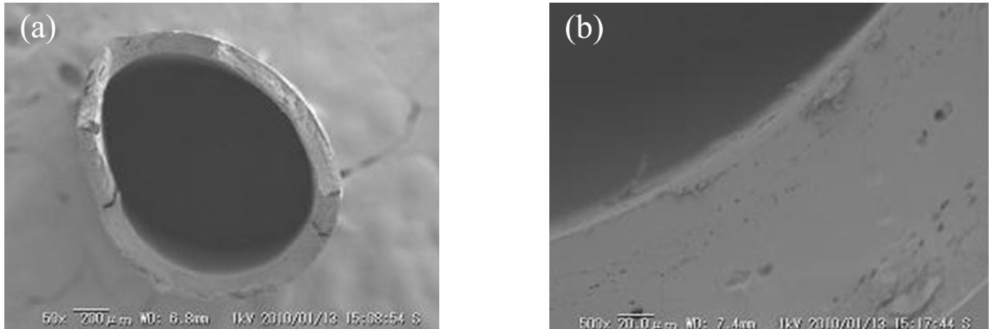
Figure 7. SEM cross-sectional image of C-HF membrane. ( a ) Overall membrane image and ( b ) close up image of the cross-section.